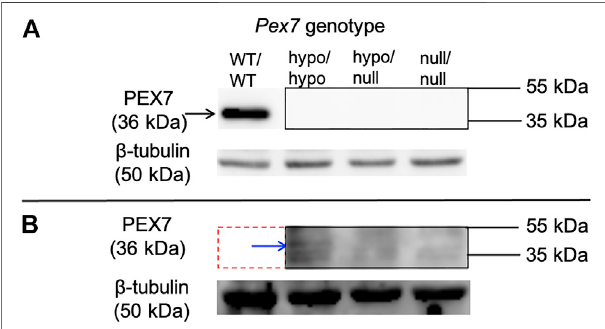
FIGURE 1 | PEX7 protein levels in the brain are undetectable in Pex7 null/null or Pex7 hypo/null and barely detectable in Pex7 hypo/hypo mice. Immunoblotting of the cerebral cortex tissue lysates showing that PEX7 protein isnot detected in any ofthe Pex7 de fi cient models at the amount of40 μ gofproteinand10 minexposuretime (A) .However,atproteinquantity of 100 μ g and exposure time of 20 min, small amounts of PEX7 protein are only detected in Pex7 hypo/hypo mice (blue arrow) (B) , the red dotted line represents the omitted Pex7 WT/WT lane due to overexposure. β -tubulin was used as a loading